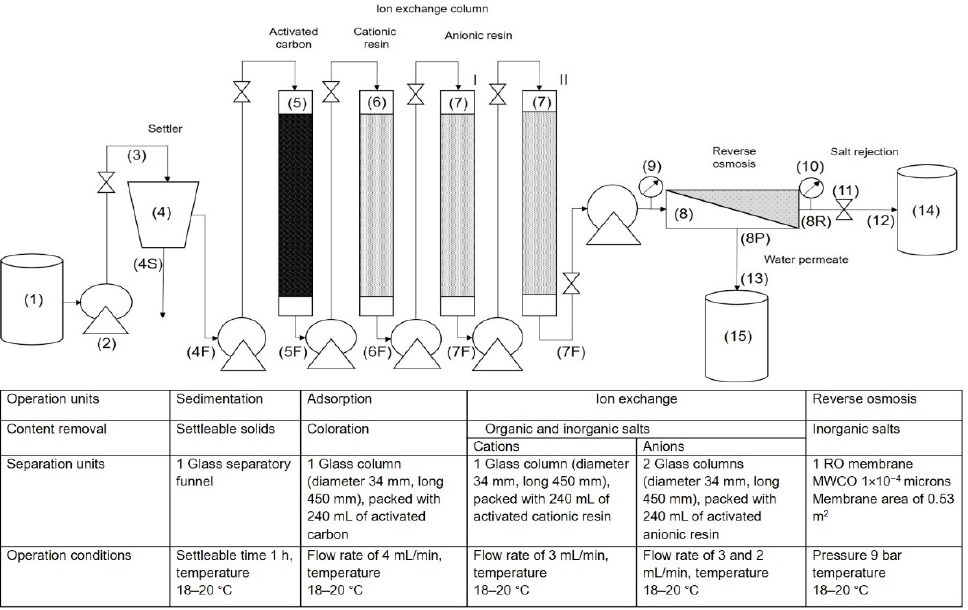
Figure 3. Diagram of the treatment process of industrial effluent treatment for water recovery.